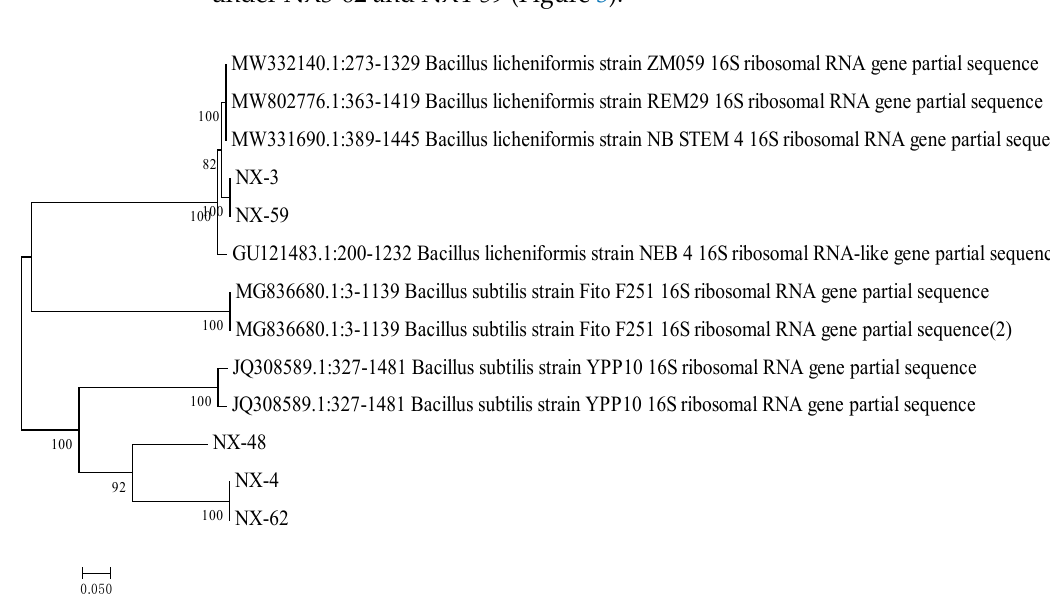
Figure 2. Phylogenetic tree of salt-tolerant (NX-3 and NX-4) and growth-promoting strains (NX-48, NX-59, and NX-62).